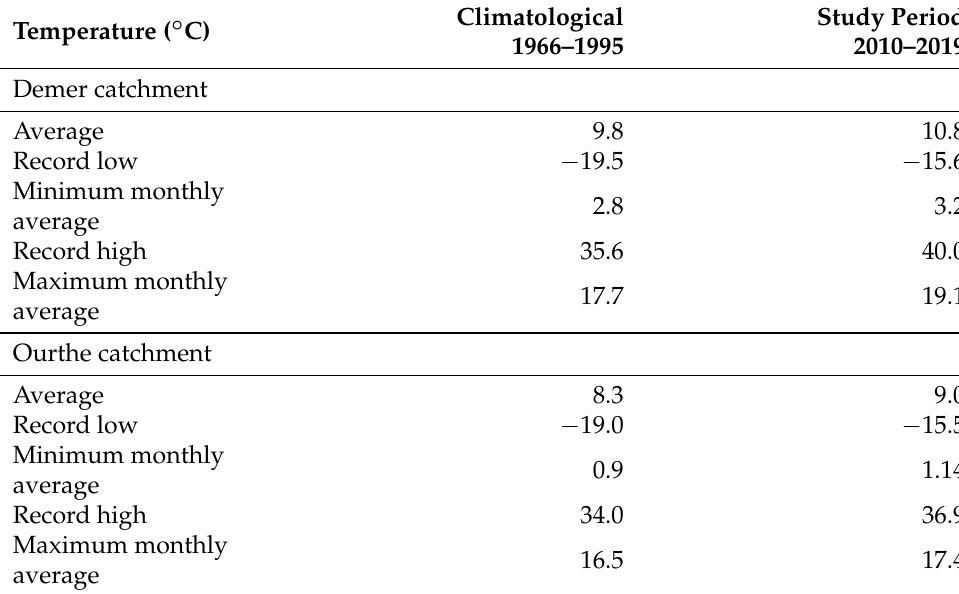
Table 3. Synoptic temperature climatology (areal